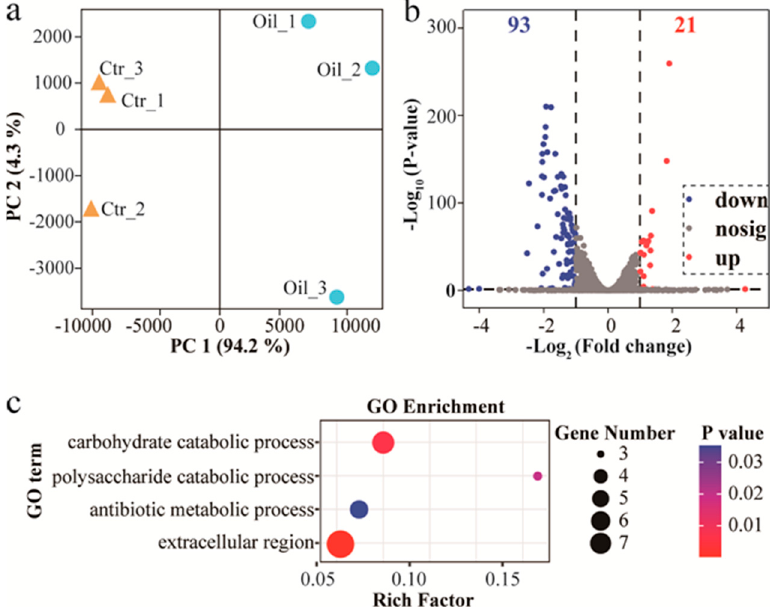
Figure 4. A plot of PCA analysis between samples ( a ), a volcano of DGEs ( b ), and a plot of enriched GO terms ( c ) was described, respectively.